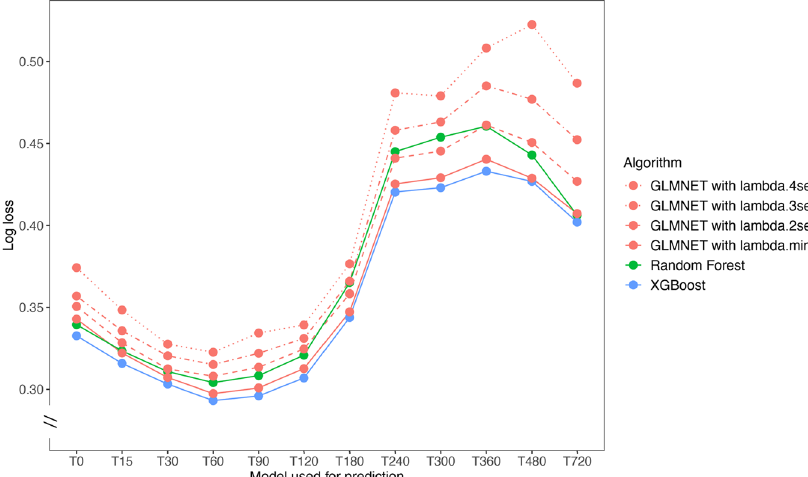
Fig. 4 Comparison of model performance of XGBoost, Random Forest and Logistic Regression on test set. For each set of 12 models (T0 to T720), the log loss achieved by each algorithm is shown as a circle with a line to link circles representing the same algorithm. Logistic regression (LR) results (in red) are shown with diminishing line solidity as lambda, the penalty value, is pushed towards greater regularisation. Lamda.min is the value of lambda with minimum cross-validated error, which is the optimal model. Lambda.2se is the value that gives the most regularised model such that the cross-validated error is within 2 standard errors of the minimum. Lambda.3se and Lambda.4se are within 3 and 4 standard errors visual inspection of the QQ plots, there is very good concurrence admissions at each prediction time. Figure 5 uses QQ plots to between the predicted distributions and observations after Step 3. evaluate the concordance between observations and the pre- (Concurrence at Step 3 was worse when using only 3 rather than dicted distributions created at Steps 3, 5 and 7 of the prediction 12 models at Step 2, as explained in Supplementary Note 7 and pipeline (see Methods for more about the intervening steps). From